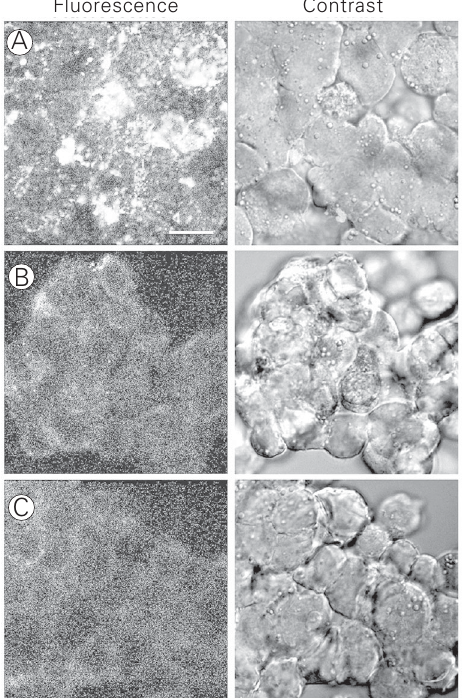
± SD for 3-4 samples. SCLC = small cell lung cancer; SL = non-targeted liposomes; SLG = antagonist G-targeted liposomes; SLP = substance P-coupled liposomes.